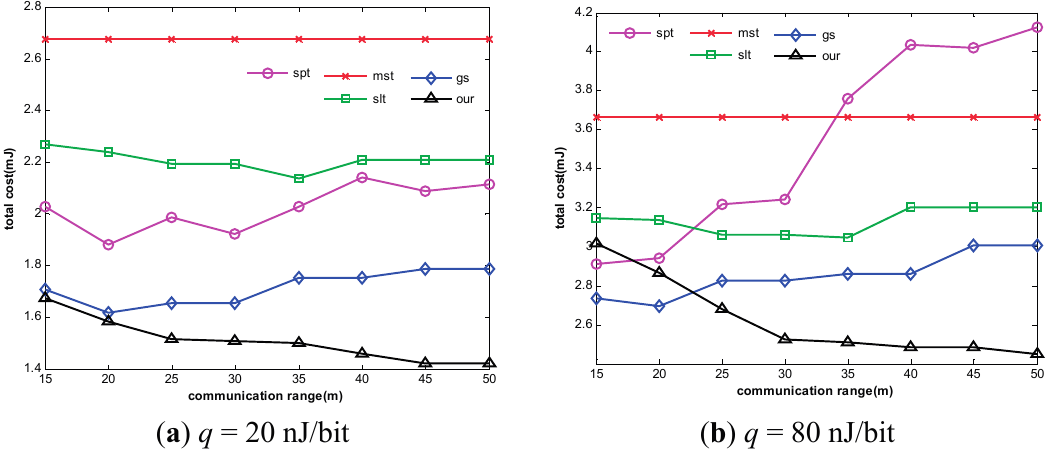
to energy consumption when k = 15. c